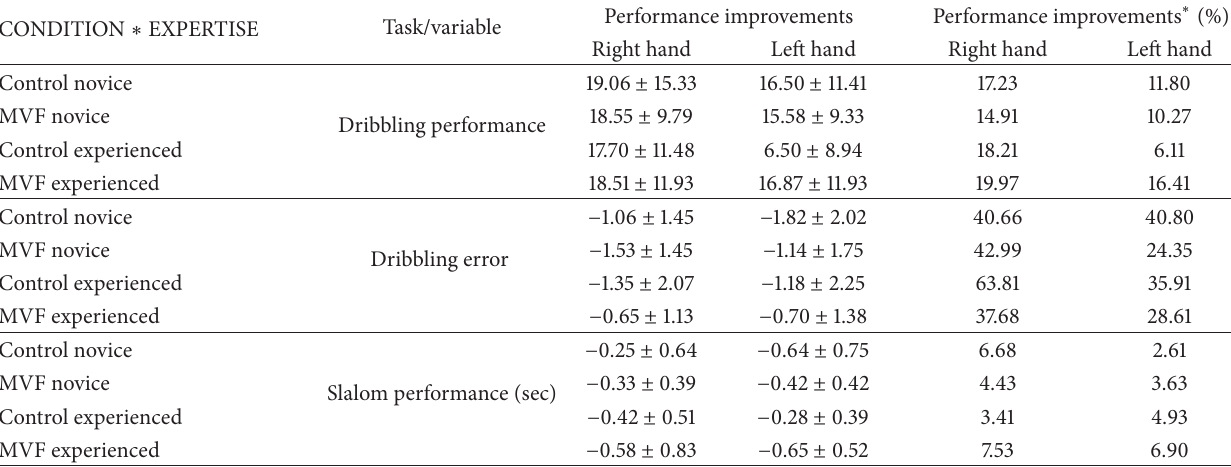
Table 2: Absolute and relative performance improvements for all test variables separated by CONDITION ∗ EXPERTISE. Shown are mean values along standard deviations.